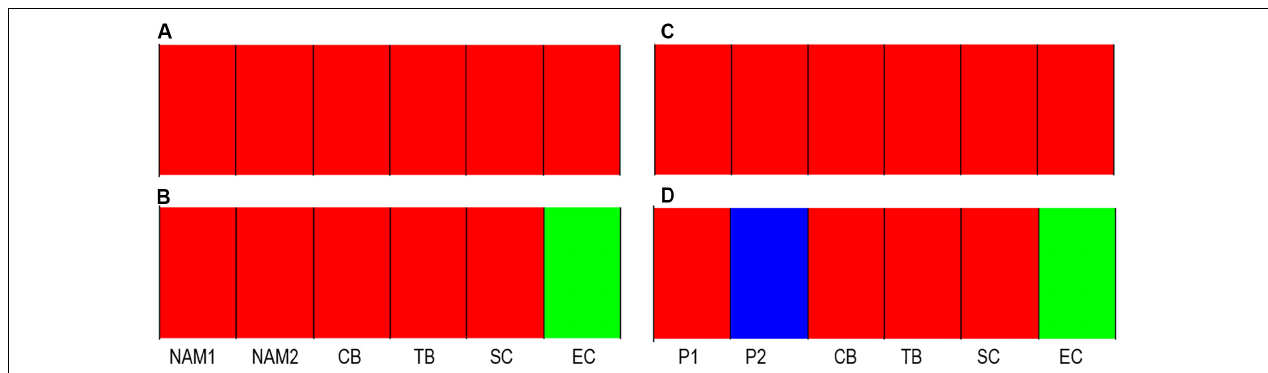
FIGURE 3 | BAPS Bayesian clustering analysis for full (neutral and outlier loci – A ) and outlier (B) datasets for the 2017 samples, as well as full (C) , and outlier datasets (D) for the South African comparisons. Pool names as per Table 1 .